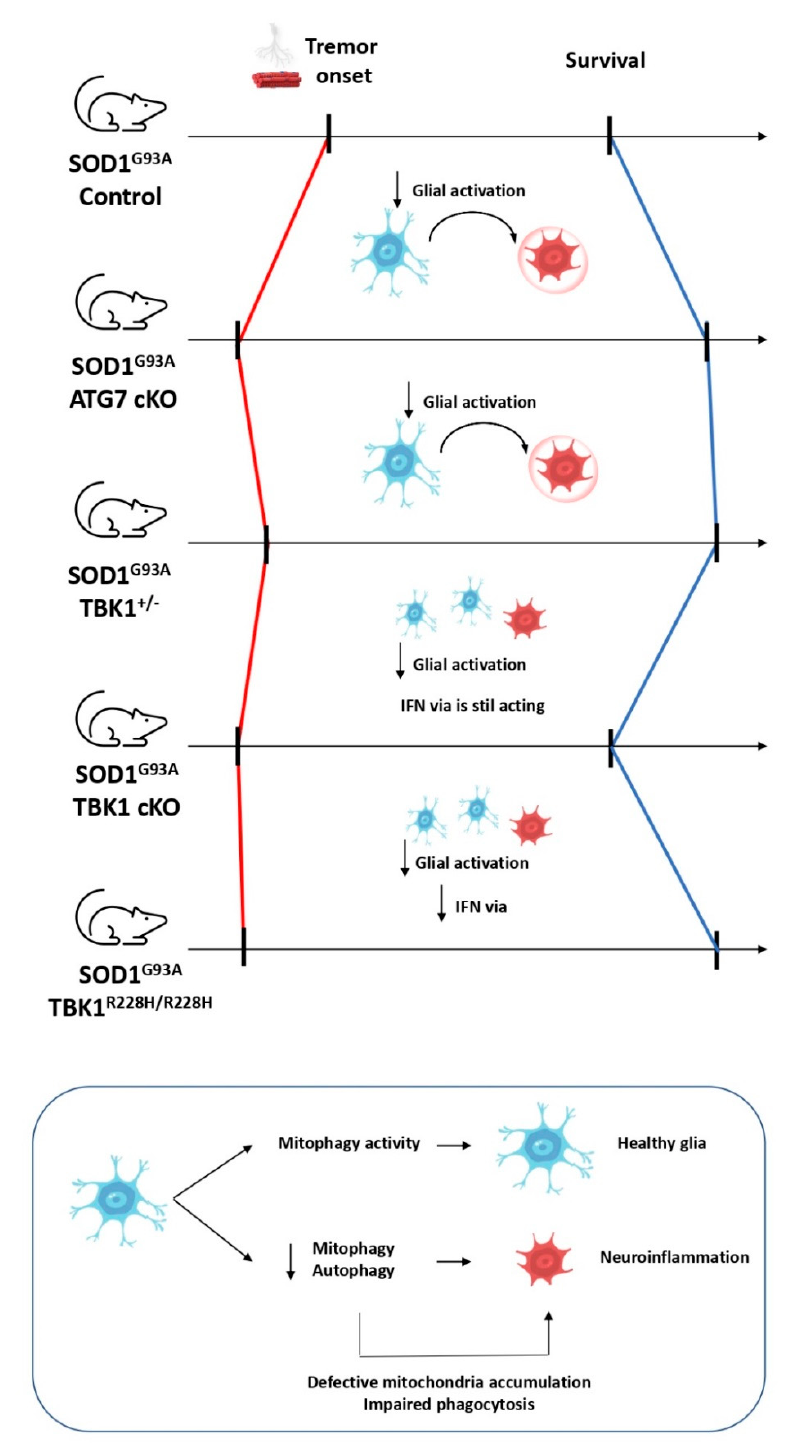
Figure 5. ALS progression presents a noncell autonomous nature. Selective deletion of autophagy genes in motoneurons causes earlier denervation in these cells. However, the SOD1 mouse model presents an extended survival, probably due to the role of glia cells in neuroinflammation.